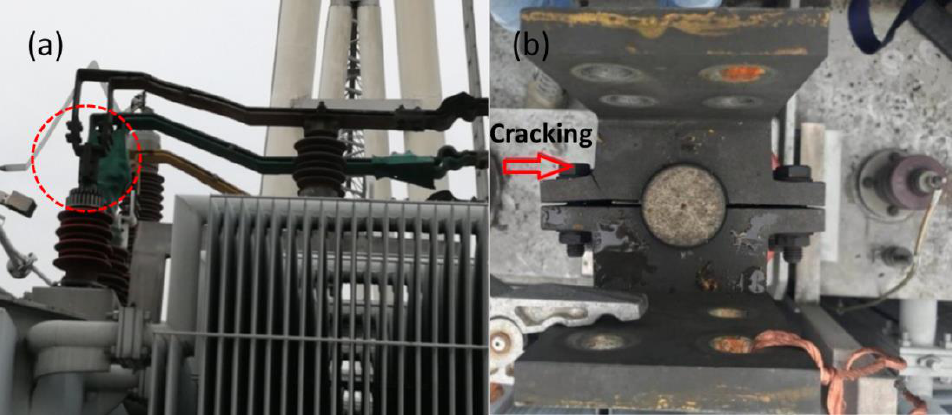
Figure 1. ( a ) The brass bushing clamp mounted on the main transformer. ( b ) General view of the cracked brass clamp.